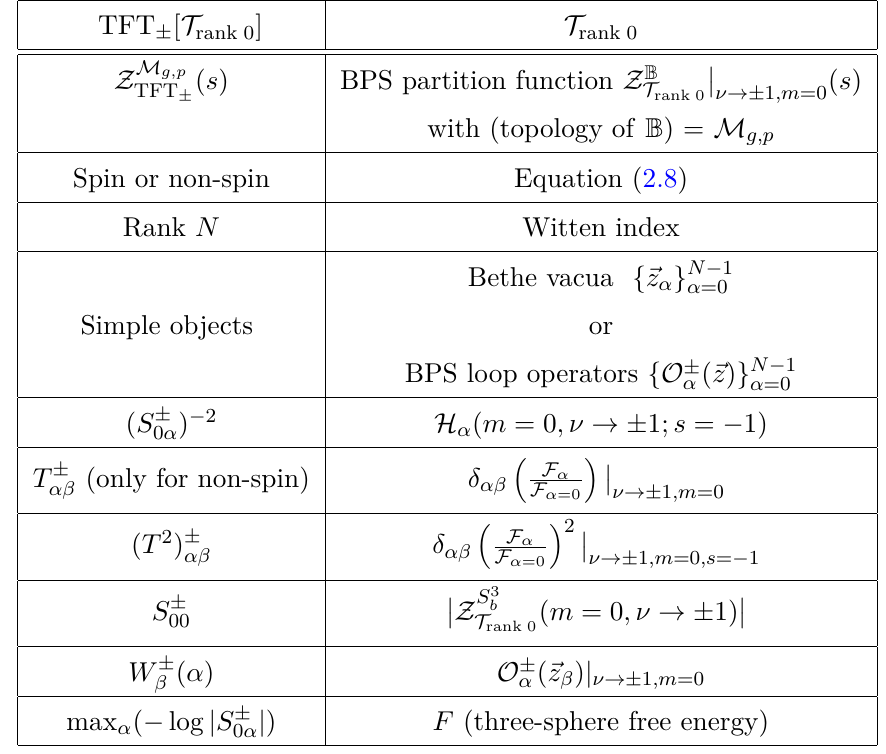
and Table 1 . Basic dictionaries in (rank 0 SCFT)/(non-unitary TQFTs) correspondence. S ± αβ are modular matrices of TFT [ T ] . We define W ( α ) := S αβ = h β |O A T ± | β i , see (A.52), ± rank 0 β α αβ S 0 β from which one can compute S-matrix S = W ( α ) W ( β ) S . H and F are handle gluing and αβ β 0 00 α α fibering operator at the α -th Bethe-vacuum respectively, see (A.40) and (A.43). O corresponds α =0 to the trivial loop and W (0) = 1 . The rank of a TFT (not to be confused with the rank of its β associated 3D N = 4 SCFT) is defined as the dimension of H ( T 2 ) for non-spin case while is defined as the dimension of H ( T 2 ) , i.e. Hilbert-space in NS-NS sector, for spin case. Similarly, the S and −− T matrices (resp. S and T 2 ) for non-spin TQFT case (resp. spin TQFT case) are modular matrices acting on H ( T 2 ) (resp. H ( T 2 ) ). Simple objects are in one-to-one with a basis of H ( T 2 ) (resp. −− H −− ( T 2 ) ) for non-spin TQFT case (resp. spin TQFT case). We refer readers to appendix A.2